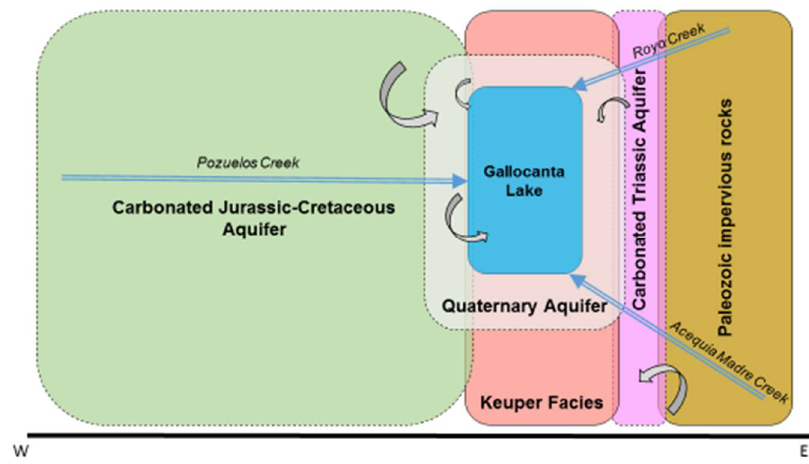
Figure 2. Hydrogeological conceptual model at the Gallocanta Basin.